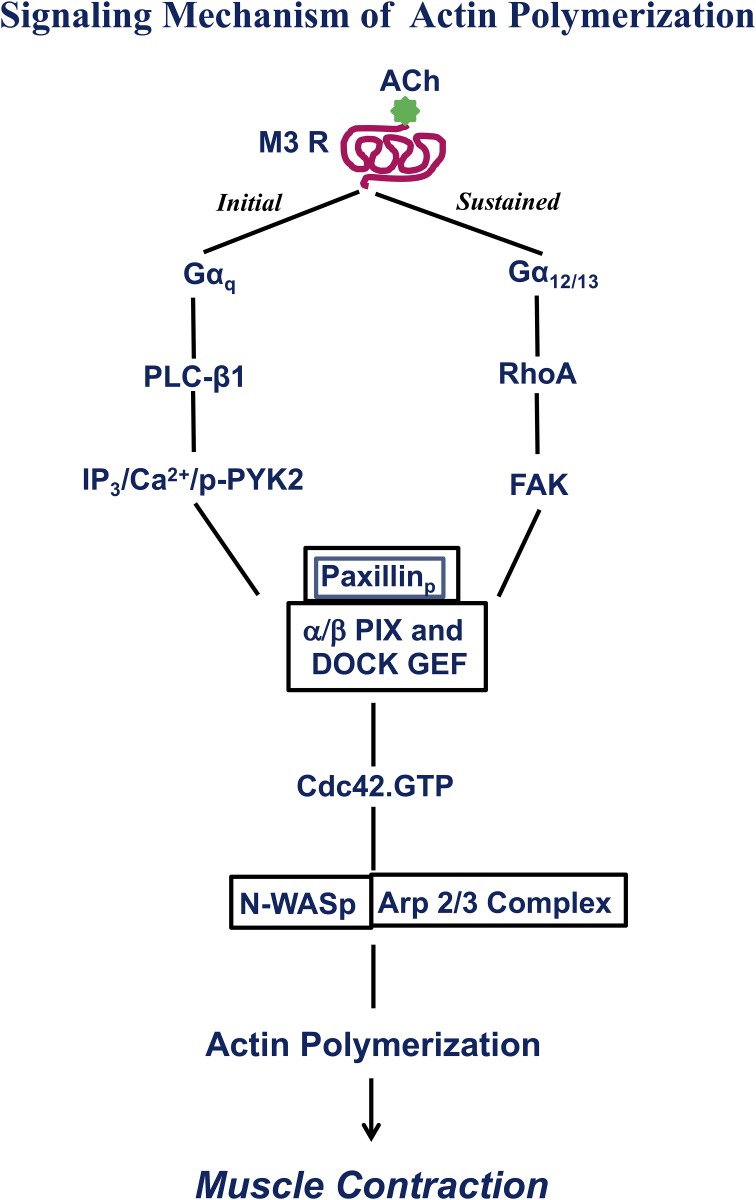
Pathways mediating initial and sustained contraction via actin polymerization by ACh.Initial contraction and actin polymerization induced by acetylcholine involve Gq-dependent PLC- activation, IP3 generation and Ca2+ release, and Ca2+ dependent activation of Pyk2. Sustained contraction and actin polymerization involve G12/13-dependent activation of RhoA, which recruits focal adhesion proteins such as FAK and paxillin to the membrane. FAK and paxillin interact at the adhesome. Phosphorylation of paxillin by activated FAK and Pyk2 facilitates the formation of complex containing paxillin with the Cdc42 GEFs, Pix and DOCK 180. This complex induces activation of Cdc42. Activation of Cdc42 in turn catalyzes the activation of neuronal Wiskott-Aldrich syndrome protein (N-WASp), which interacts with Arp2/3 complex to induce actin polymerization and muscle contraction.